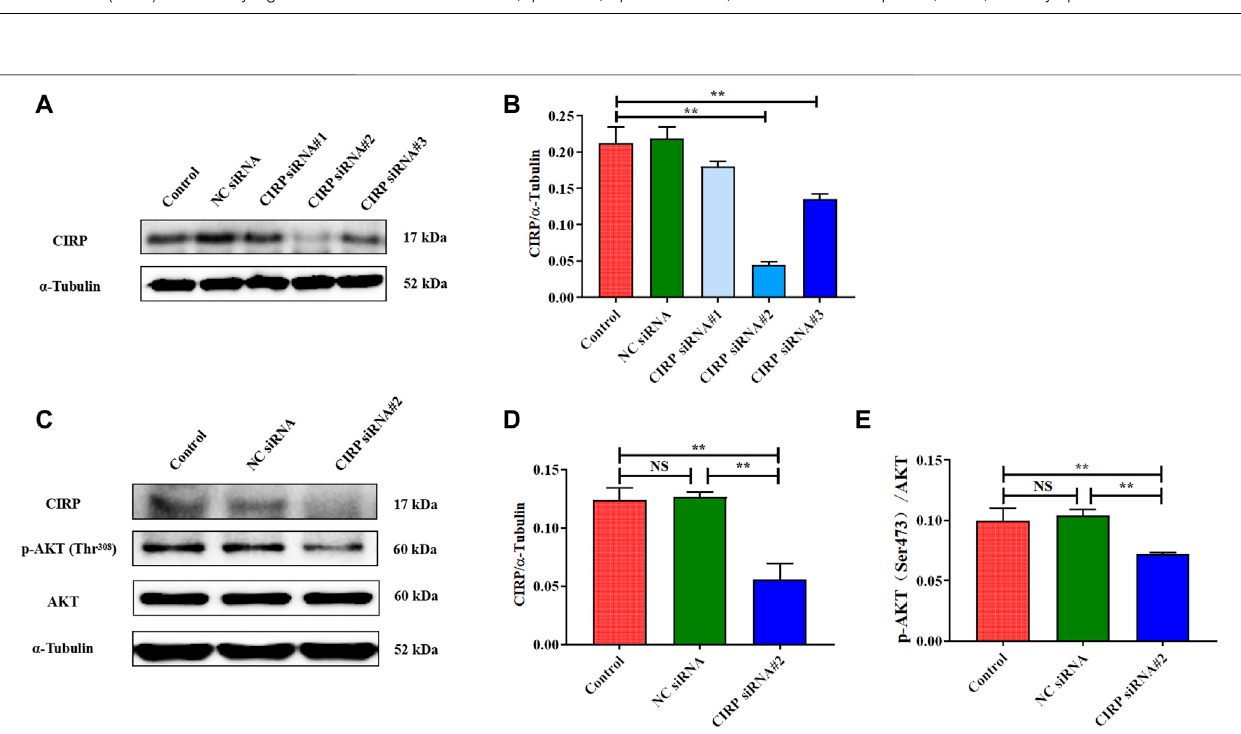
FIGURE6| EffectsofmildhypothermiaandCIRPoverexpressionononapoptosisofC2C12cells. (A) Westernblottingresultsofapoptosisrelatedproteinsineach group. The protein expression levels of Cleaved Caspase-3 (B) , the expression ratio of Bax and Bcl-2 (C) in the skeletal muscles of mice. The data are presented as the mean ± SEM (n (cid:1) 8). Statistically signi fi cant differences are indicated; * p < 0.05, ** p < 0.01. Bax, Bcl-2 assaciated x protein; Bcl-2, B-cell lymphoma-2.